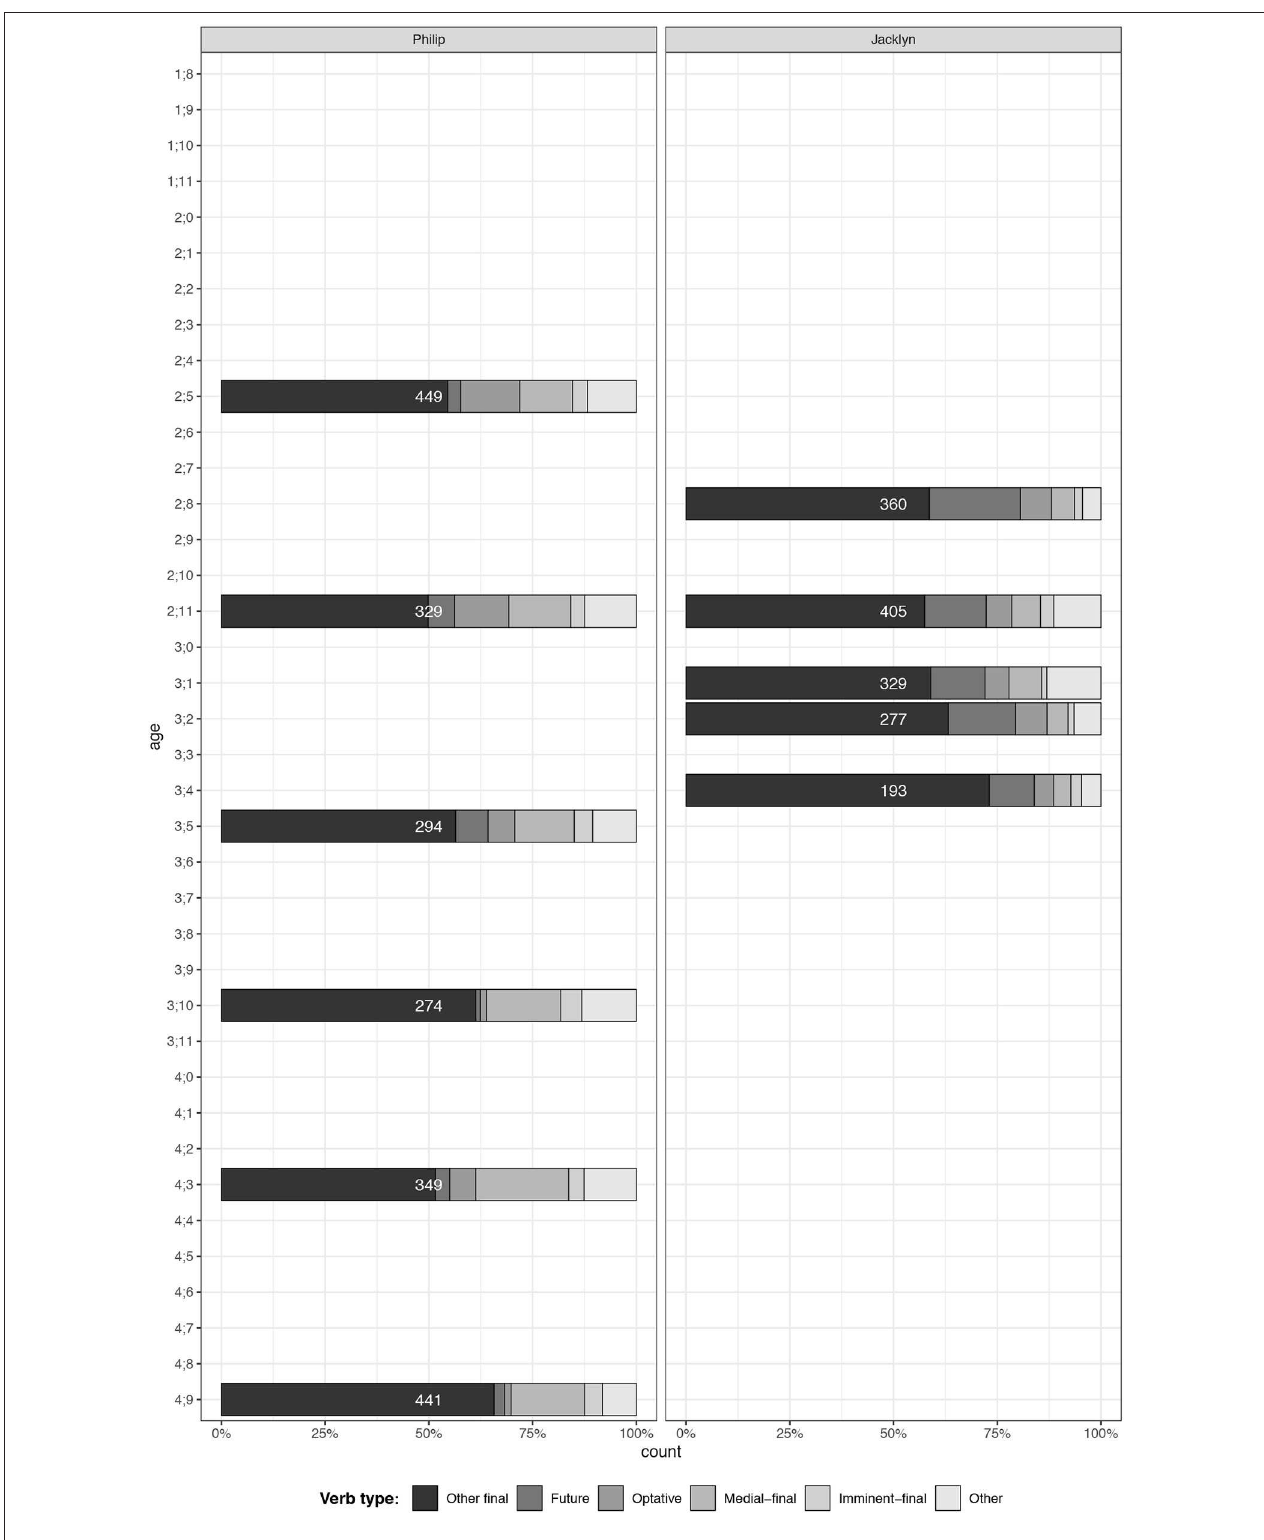
FIGURE 11 | Incidence of common construction types in adults’ speech to Philip and Jacklyn.